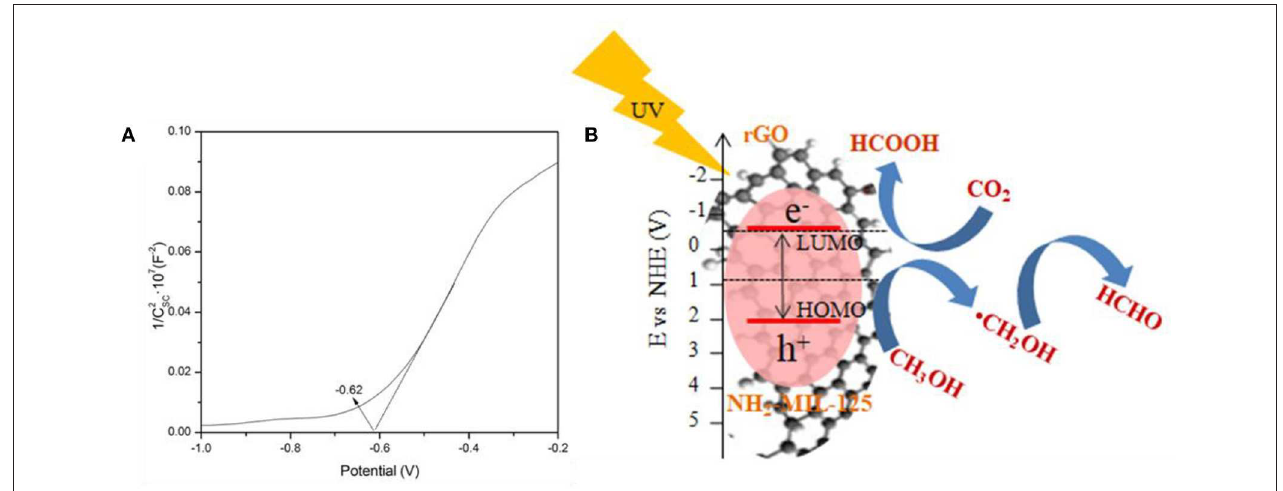
FIGURE 9 | (A) Mott-Schottky (MS) plots of NH 2 -MIL-125 and (B) schematic of the possible mechanism of photocatalytic CO 2 reduction over rGO@NH 2 -MIL-125